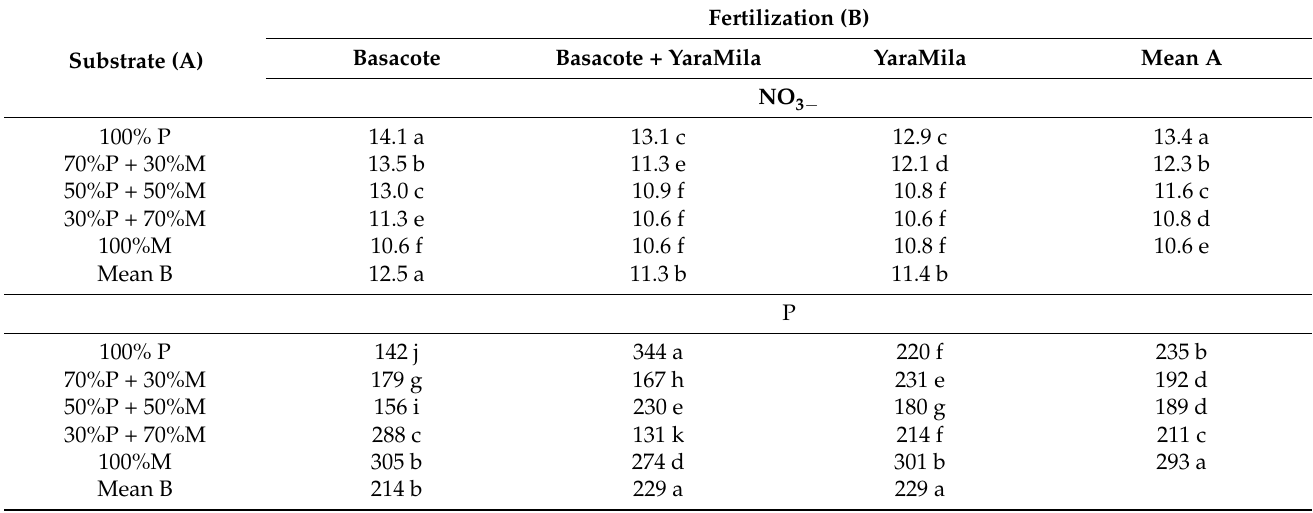
Table 11. Foliar nutrient contents (mg/g) in Hydrangea arborescence ‘Annabelle’ grown in containers with five different